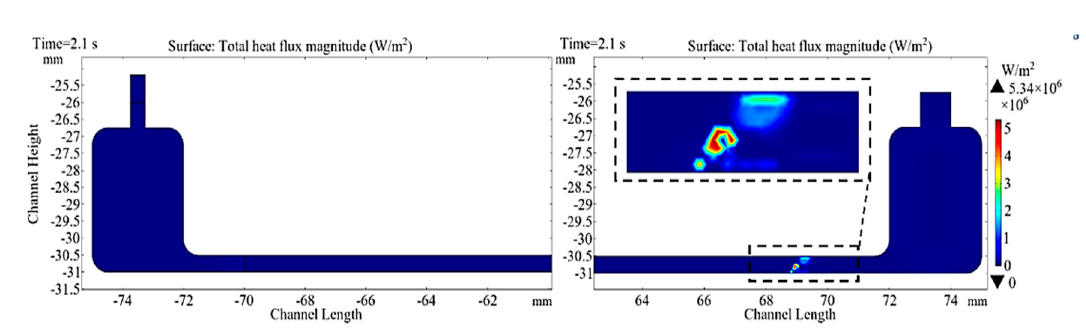
Figure 14. Dissipated heat flux distribution with the increasing temperature along the top and bottom walls.